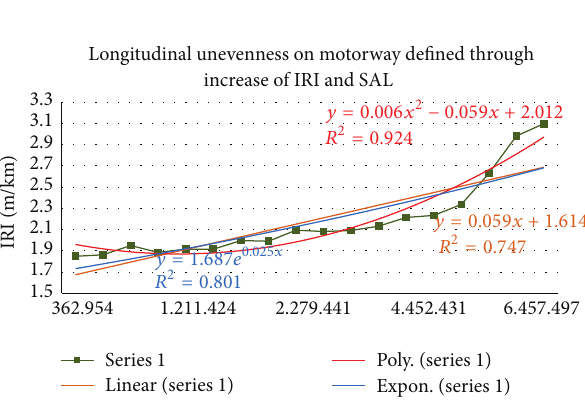
Figure 7: IRI deterioration for